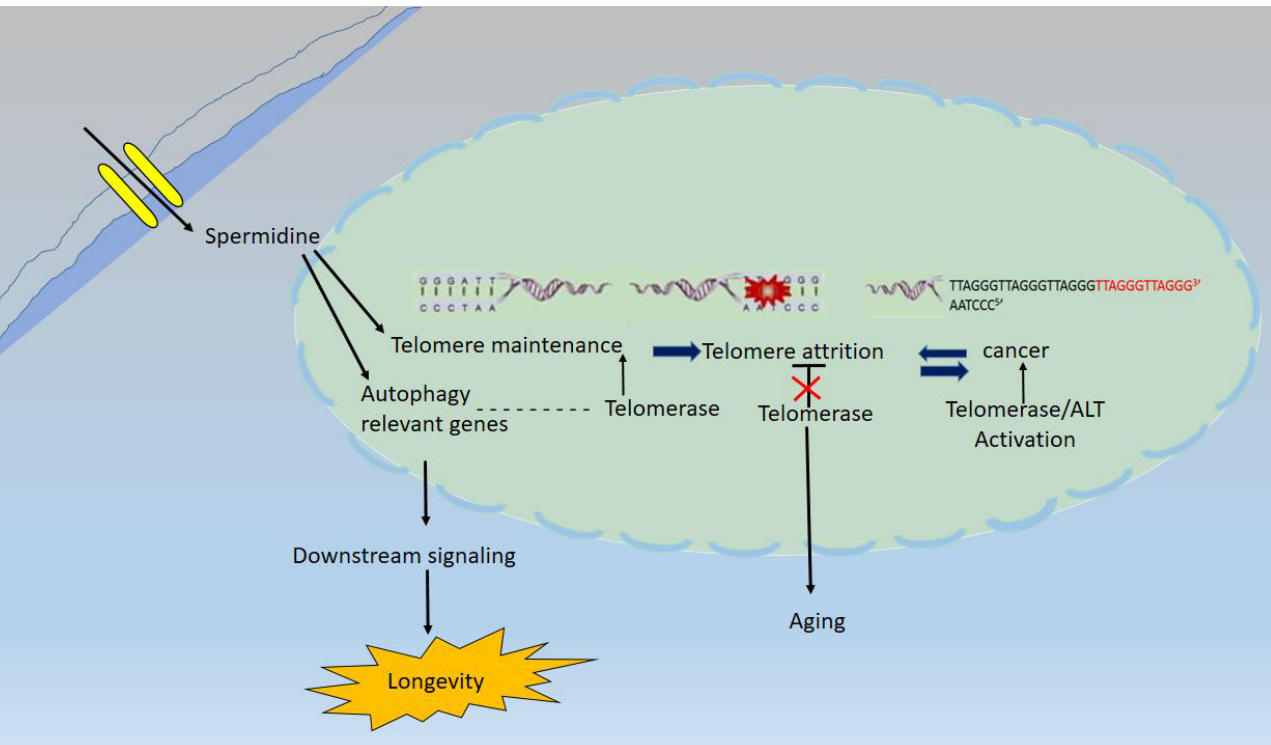
Fig.1. Impact of spermidine on telomere length on aging and cancer. Picture showing three different microenvironments after the exogenous modulation of spermidine levels in the cancerous and non-cancerous cells on the telomerase activity. In aging, lack of telomerase activity in cells leads to telomere shortening. (A) Effect of hTERT gene transduction and spermidine supplementation on telomere length in cancerous cell lines. (B) Analysis of telomere length and expression of differentially regulated genes involved in telomere maintenance and autophagy after spermidine supplementation in non-cancerous cell lines. (C) Measurement of telomere length on spermidine supplementation in ALT cell lines.